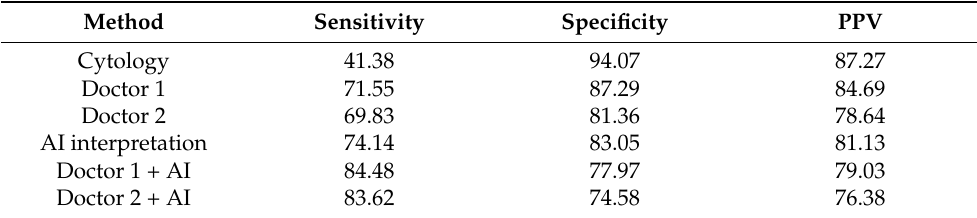
Table 3. Evaluation of the diagnostic quality of various tools in detecting high-grade or worse lesions versus less severe impressions.